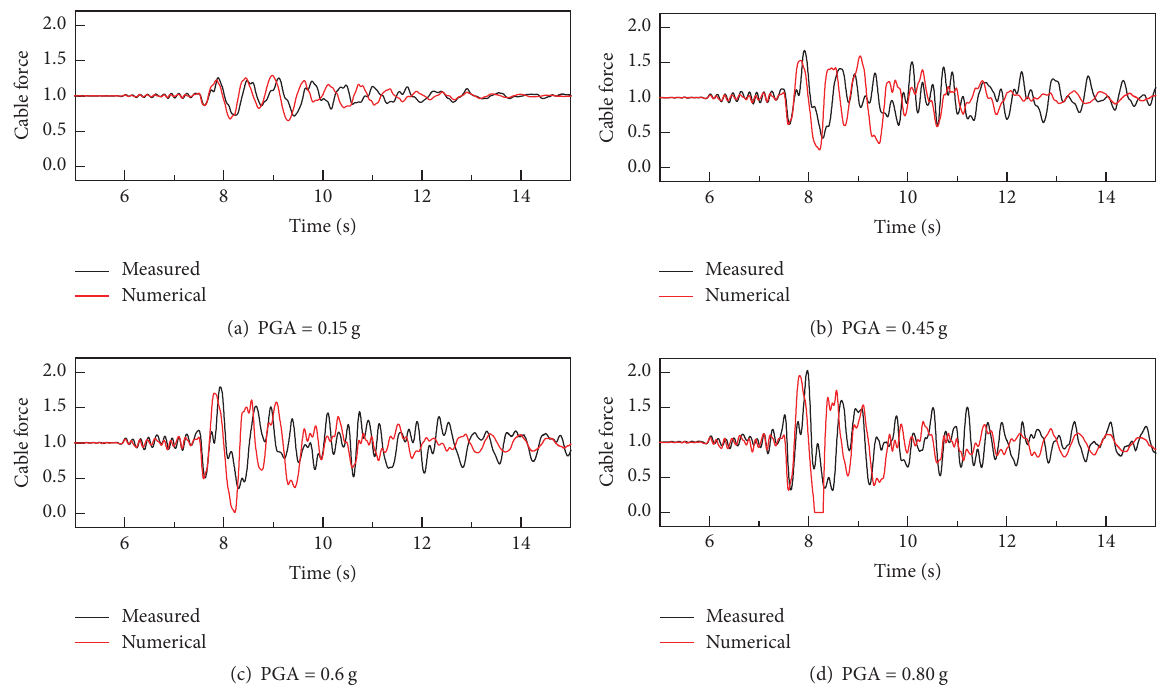
Figure 15: Comparisons of normalized cable force histories between measured and numerical results (C3).